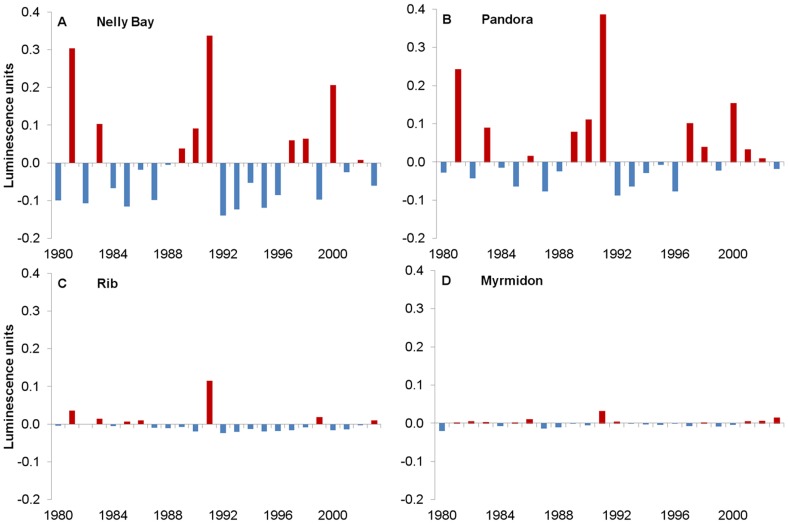
Average annual anomalies of luminescence range, 1980–1983 from coral slices.Significant positive anomaly in 1991 reflects major flood plumes transported to reefs in the inshore and mid-shelf reefs. Inshore sites: (A) Nelly Bay, (B) Pandora Reef, Mid-shelf site: (C) Rib Reef, Offshore site: (D) Myrmidon Reef.